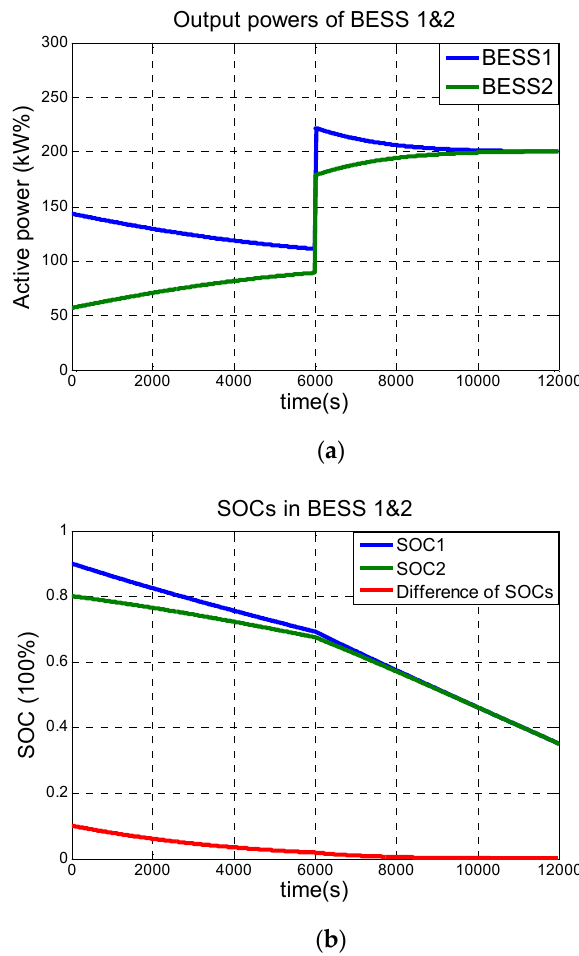
Figure 11. SOC and output power waveforms in case of a change of load at a time of 6000 s. ( a ) Waveforms of SOC and ( b ) waveforms of output powers.